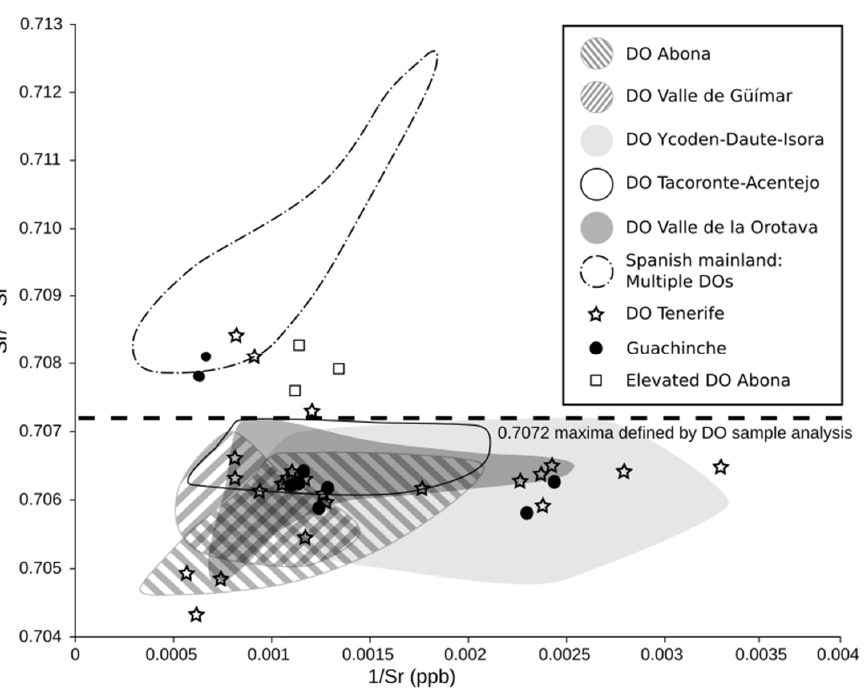
Figure 8. DO fields from Figure 4, with samples from DO Tenerife, guachinche restaurants and Spanish mainland samples (Supplementary Materials Table S4). Ninety percent of the DO registered Tenerife samples define a 0.7072 maxima for 87 Sr/ 86 Sr (also evaluated as a rank-order plot in Supplementary Materials Table S5, where a sharp inflection can be seen above this maxima).